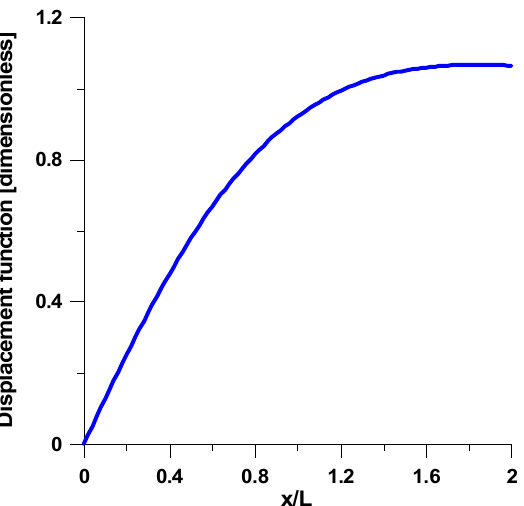
( ) ( ) xx εε cosexp1 −− —isotropic shell t/R = 0.1.